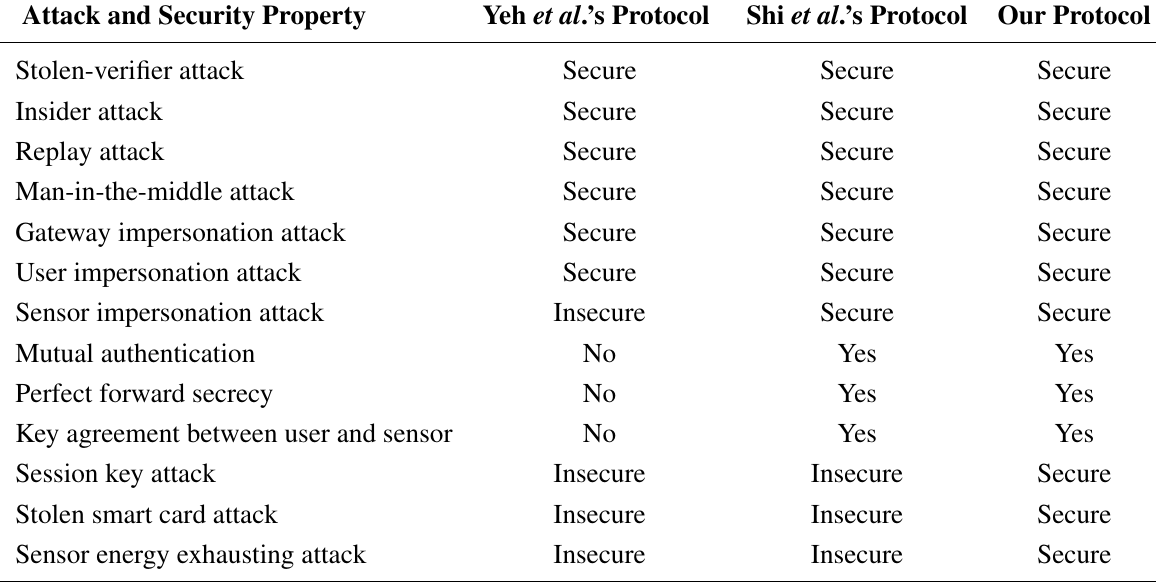
Table 5. Security